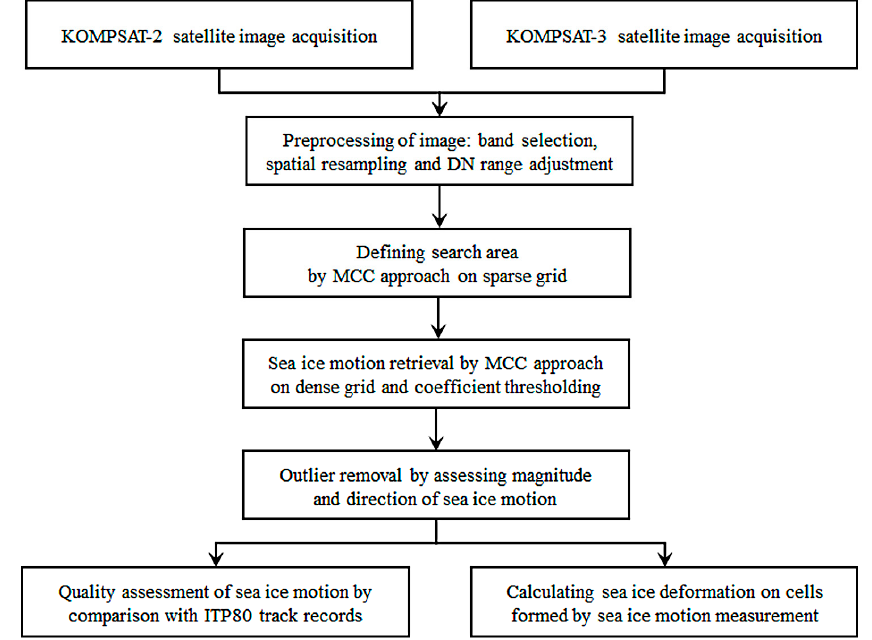
Figure 3. Working processes for sea ice motion and deformation measurements.